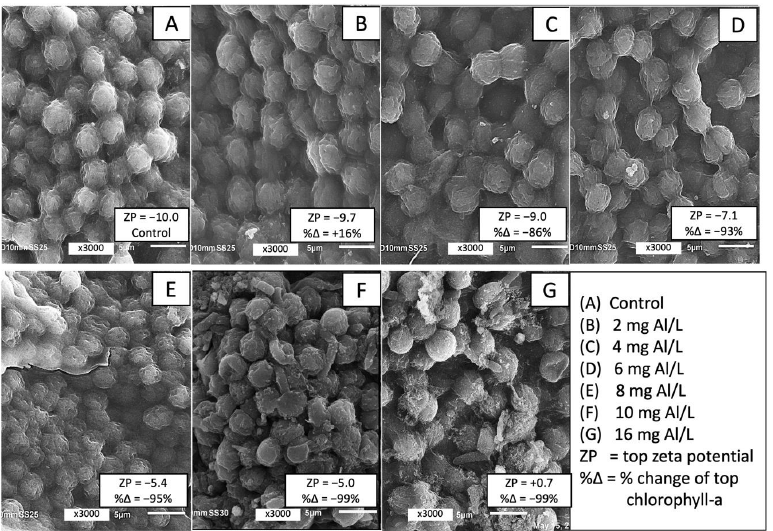
Figure 3. Scanning electron microscope images of Microcystis aeruginosa at 3000× magnification following treatment with aluminum sulfate at ( A ) 0 mg Al/L, ( B ) 2 mg Al/L, ( C ) 4 mg Al/L, ( D ) 6 mg Al/L, ( E ) 8 mg Al/L, ( F ) 10 mg Al/L, and ( G ) 16 mg Al/L.